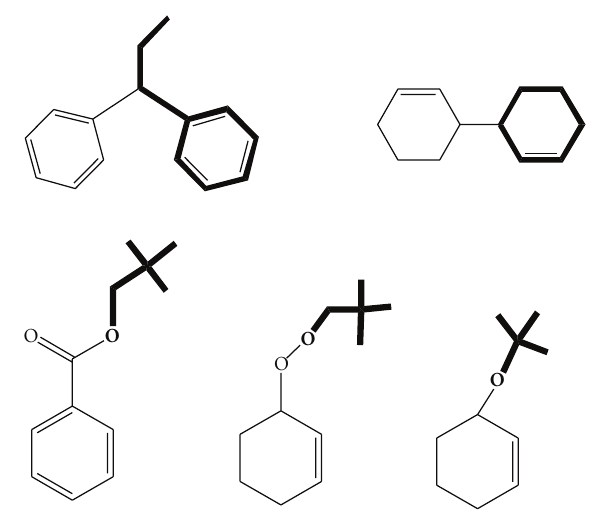
Scheme 2: Schematic representation of detected